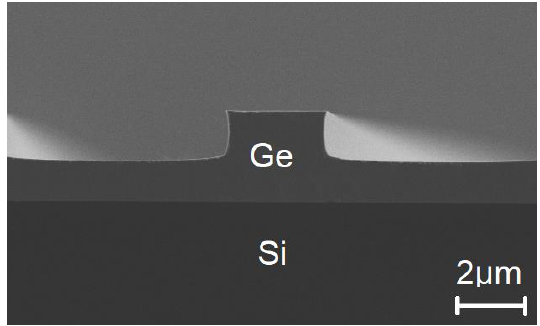
Figure 15. SEM image of a ductile machined end facet of a germanium-on-silicon waveguide.